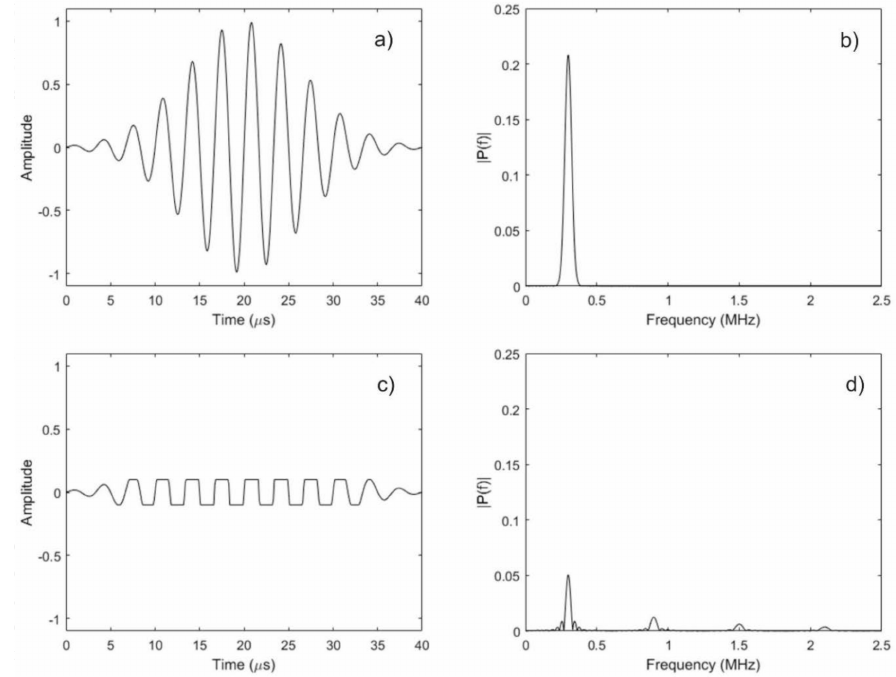
Figure 7. Illustration of the effect of clipping a sinusoid on its frequency content. The top two figures show a 300-kHz sinusoid with a Gaussian envelope applied ( a ), and its associated spectrum ( b ). The bottom two figures show the same sinusoid clipped to be within the range of − 0.1 to 0.1 ( c ), and its associated spectrum ( d ). Note how the unclipped spectrum has its energy concentrated near 300 kHz, whereas the clipped spectrum has energy at the odd harmonics of 300 kHz (i.e., 300 kHz, 900 kHz, 1.5 MHz,